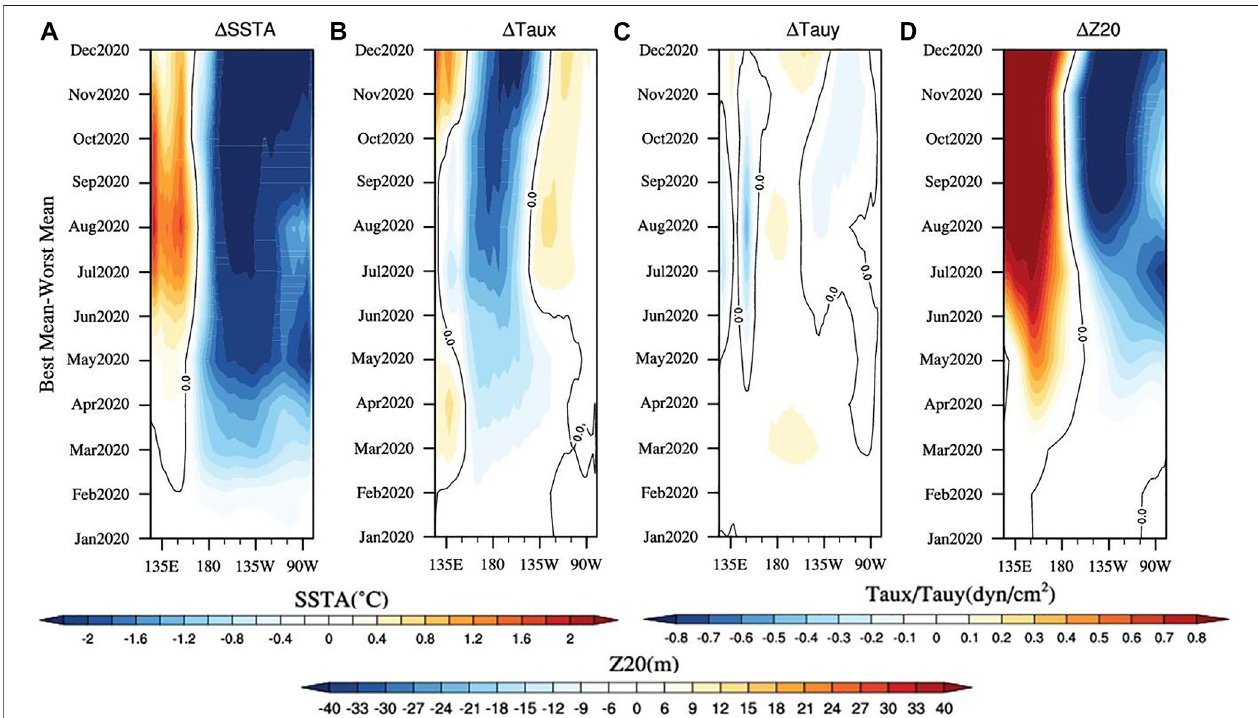
FIGURE8| Temporalevolutionofthedifferences(ensemblemeanofthebestpredictionmembersminusensemblemeanoftheworstprediction members)offour variables along the equatorial Paci fi c (averaged between 5 ° S and 5 ° N) in 2020 for (A) Δ SSTA, (B) Δ Taux, (C) Δ Tauy, and (D) Δ Z20.